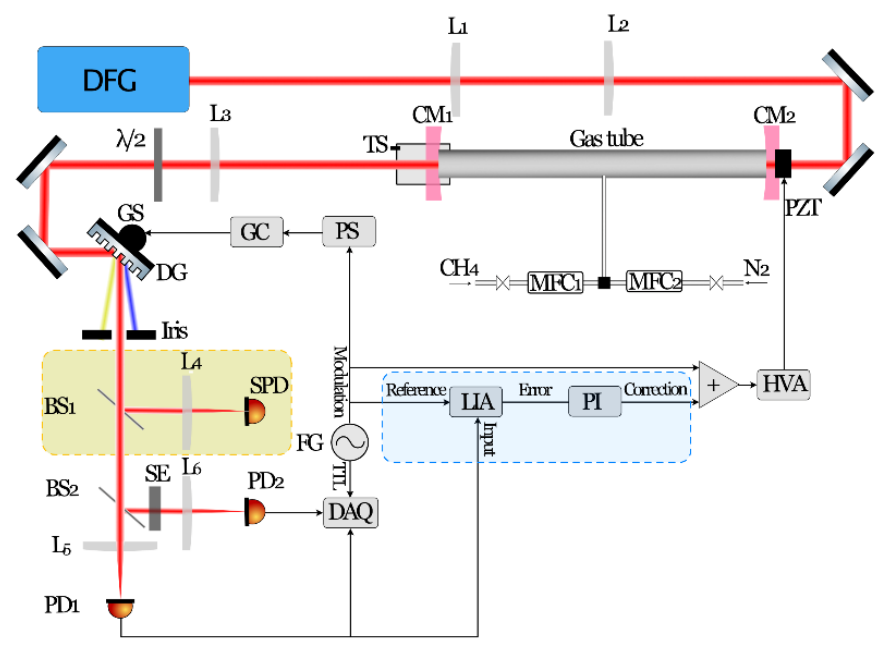
Figure 5. Schematic of the mid-infrared CF-VS setup. L 1–6 : spherical lenses; L 1–6 : plano-convex lenses; PZT: piezo transducer; CM 1–2 : cavity mirrors; TS: translation stage; λ /2: half-wave plate; DG: diffraction grating; GS: galvo scanner; GC: galvo controller; PS: phase shifter; BS 1–2 : pellicle beam splitters; SPD: split photodiode; PD 1–2 : HgCdTe photo detectors; SE: 3 mm thick silicon etalon; FG: function generator; LIA: lock-in amplifier; PI: proportional integral controller; HVA: high voltage amplifier; DAQ: multichannel data acquisition card.